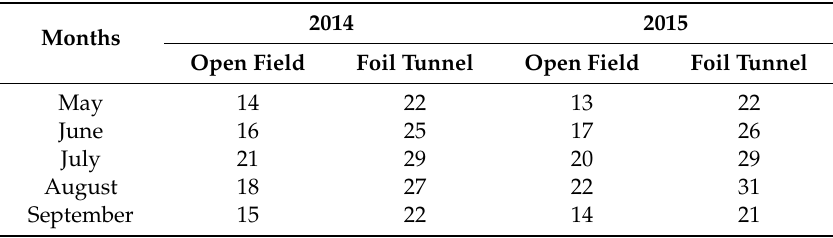
Table 1. Mean temperatures in the vegetation season of 2014 and 2015 ( ◦